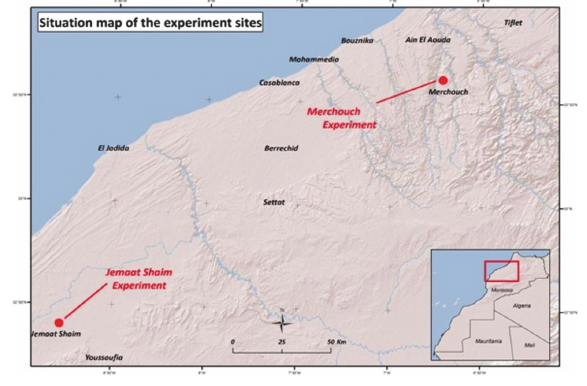
Figure 1: Maps showing the two sites.